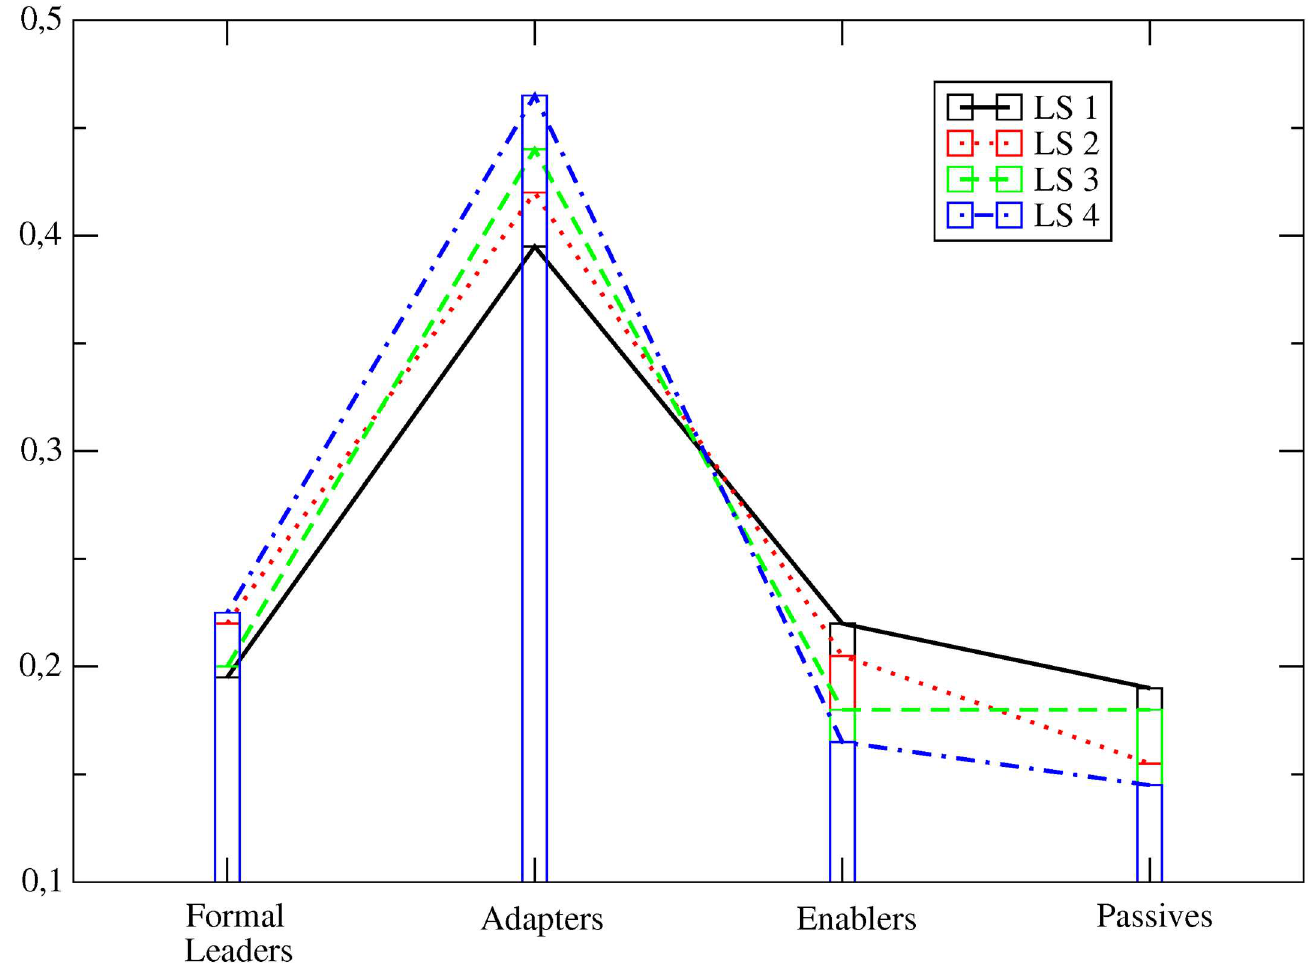
Fig 2. Constellations of complexity leadership functions. Constellations of complexity leadership functions that were found for each leadership system (LS), obtainedfrom the distributionof roles as evaluatedby all participantswithin a group to which a specific LS instruction was given.